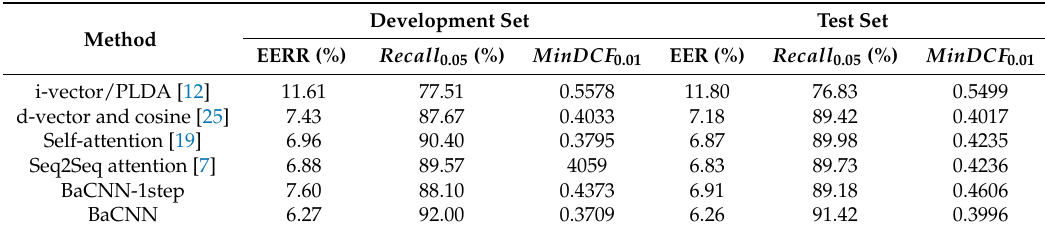
Table 4. Comparison with state-of-the-art methods on the development set and the test set. Method